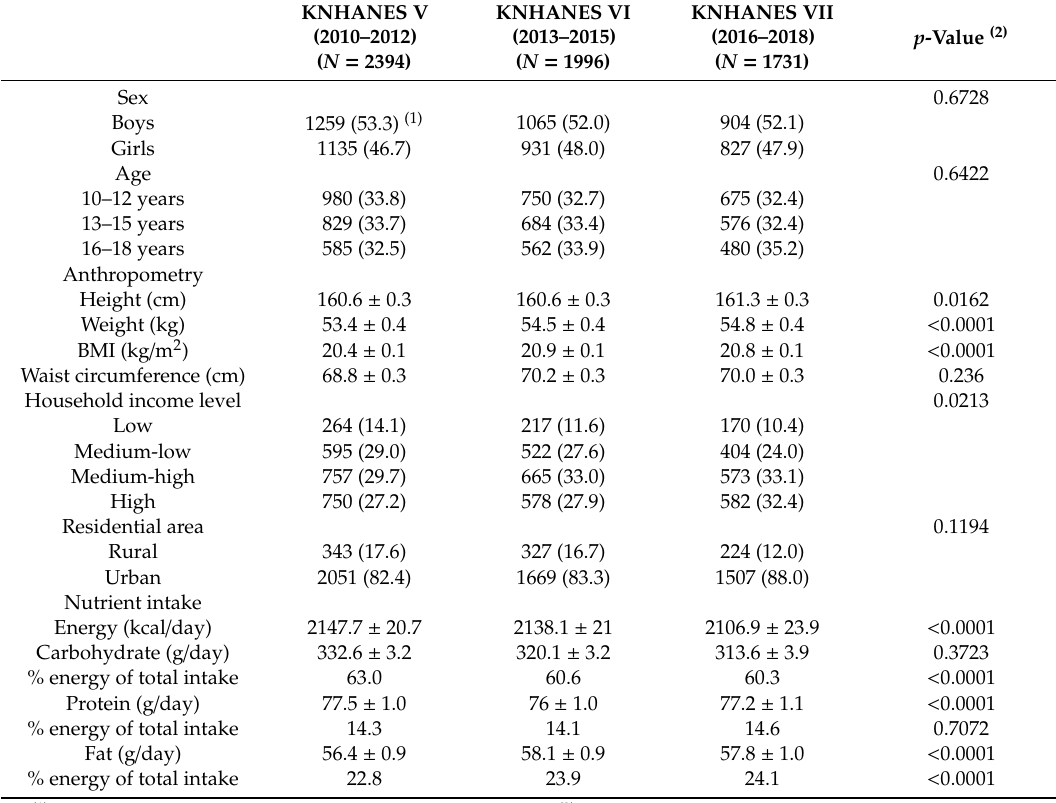
Table 1. Sample size by survey year and demographic characteristics of subjects who completed